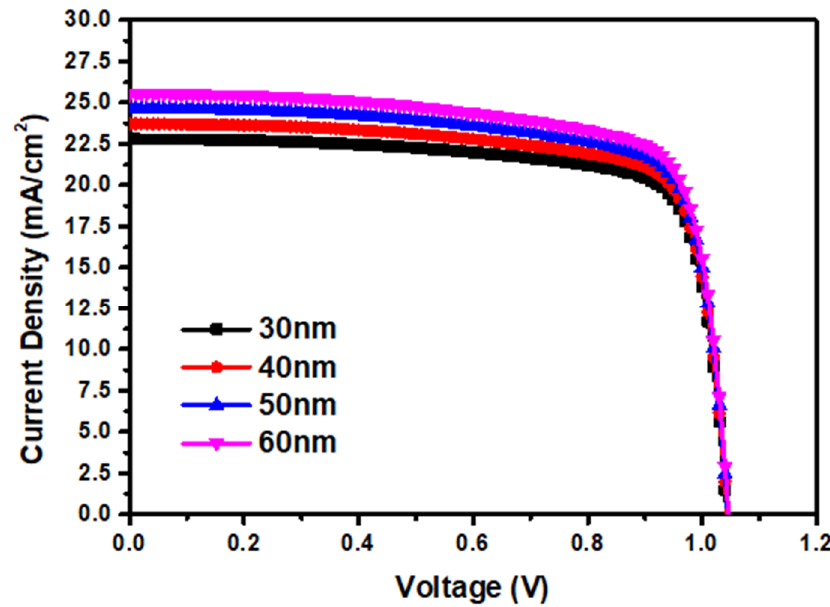
Figure 6. Current density–voltage ( J–V) curves for various NiO x thicknesses.